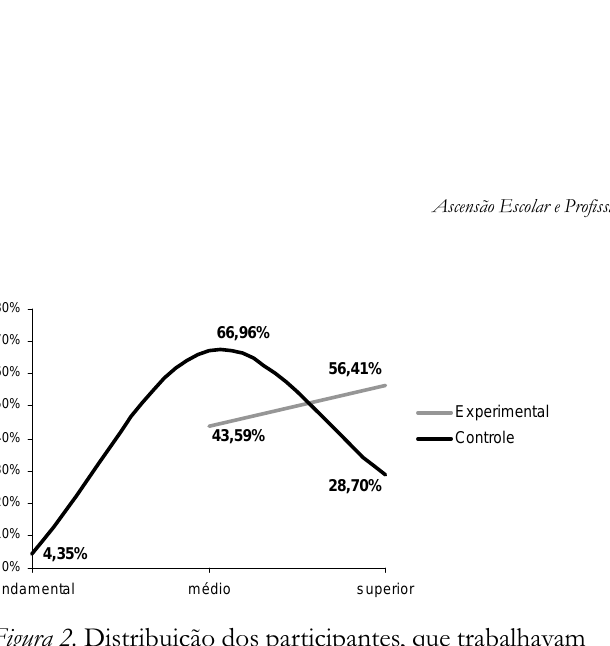
Figura 3. Alunos que estudavam e trabalhavam, nos grupos de ensino mØdio e